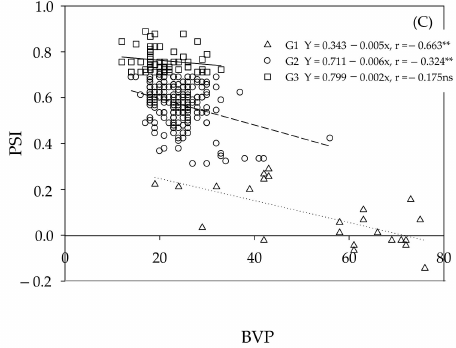
Figure 5. Relationship between PSI and GY ( A ), BVP and GY ( B ), PSI and BVP ( C ) in each group. Triangle = G1 (insensitive), circle = G2 (weakly sensitive), square = G3 (strongly sensitive), while ns, *, and ** represent not significant and significant at p < 0.05 and p < 0.01,